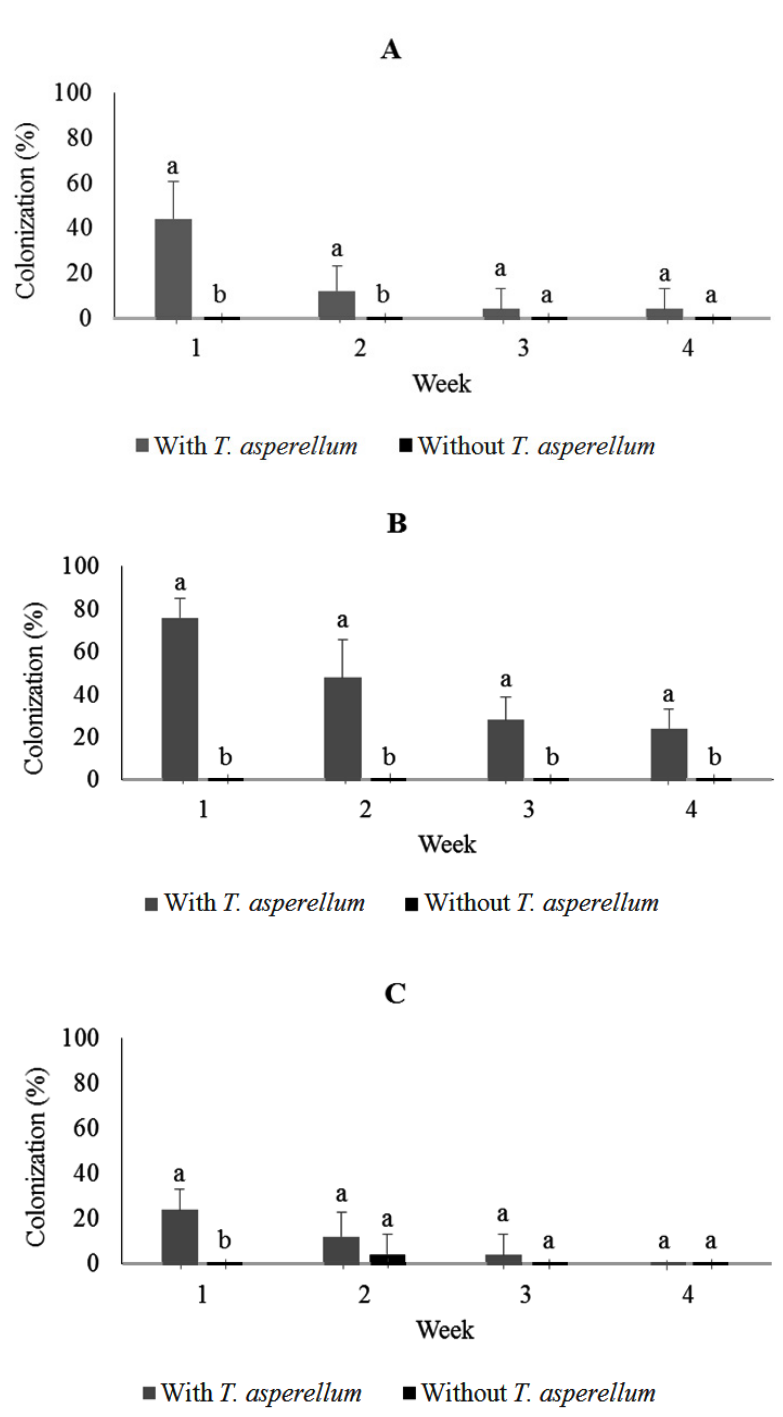
Fig. 1. Colonization of Trichoderma asperellum in leaf (A), stem (B), and root (C) tissues at one, two, three, and four weeks post-inoculation through foliar spraying. Means of colonization at the same time followed by the same letter are not significantly different according to T-test